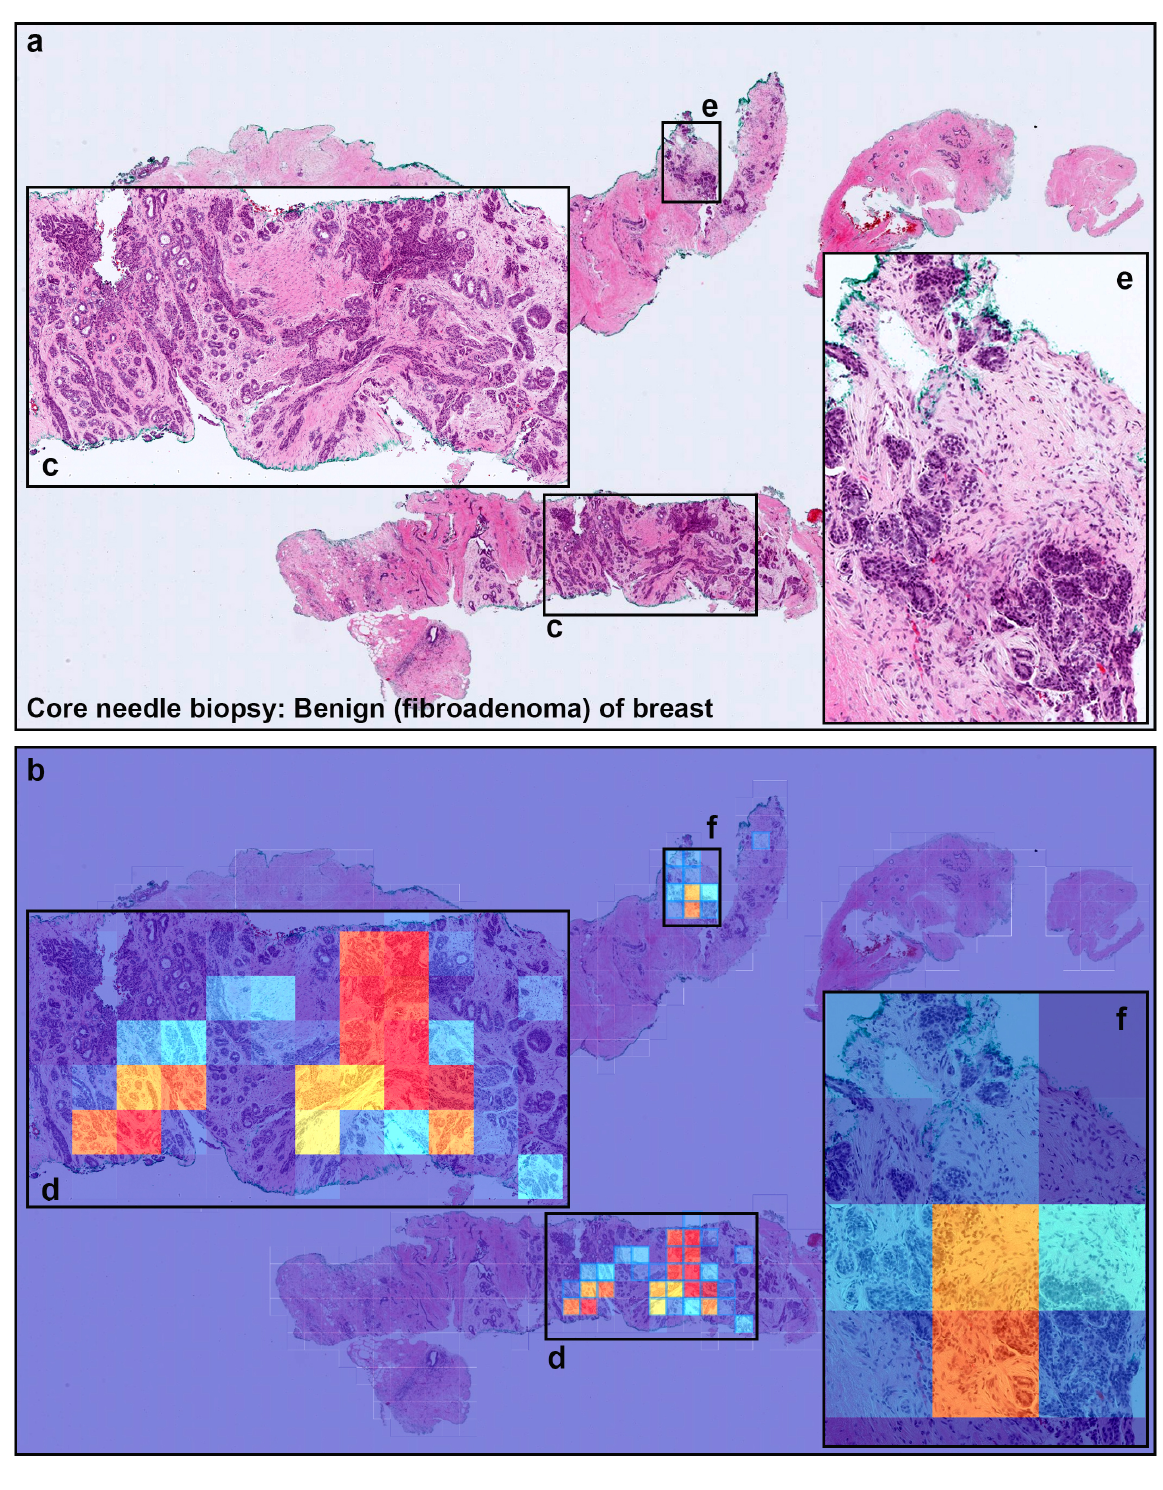
Figure 5. A representative example of invasive ductal carcinoma (IDC) false positive prediction output on a case from core needle biopsy test set. Histopathologically ( a ), this case is a benign lesion (fibroadenoma). Heatmap images ( b , d , f ) exhibited false positive prediction of IDC using transfer learning from ImageNet model (magnification × 10). The ductular structures in fibroadenoma with a pericanalicular pattern ( c – f ) would be the primary cause of false positive due to its morphological analogous to ductular structures in